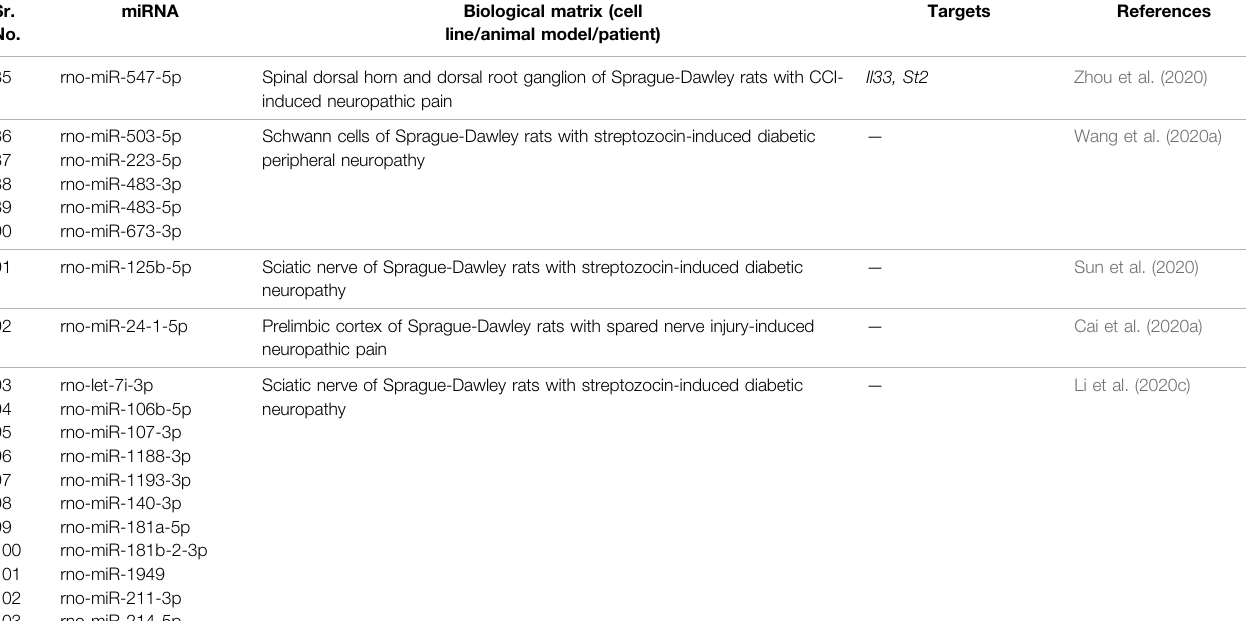
TABLE 6 | ( Continued ) Downregulated rat microRNAs involved in neuropathic pain. Sr.